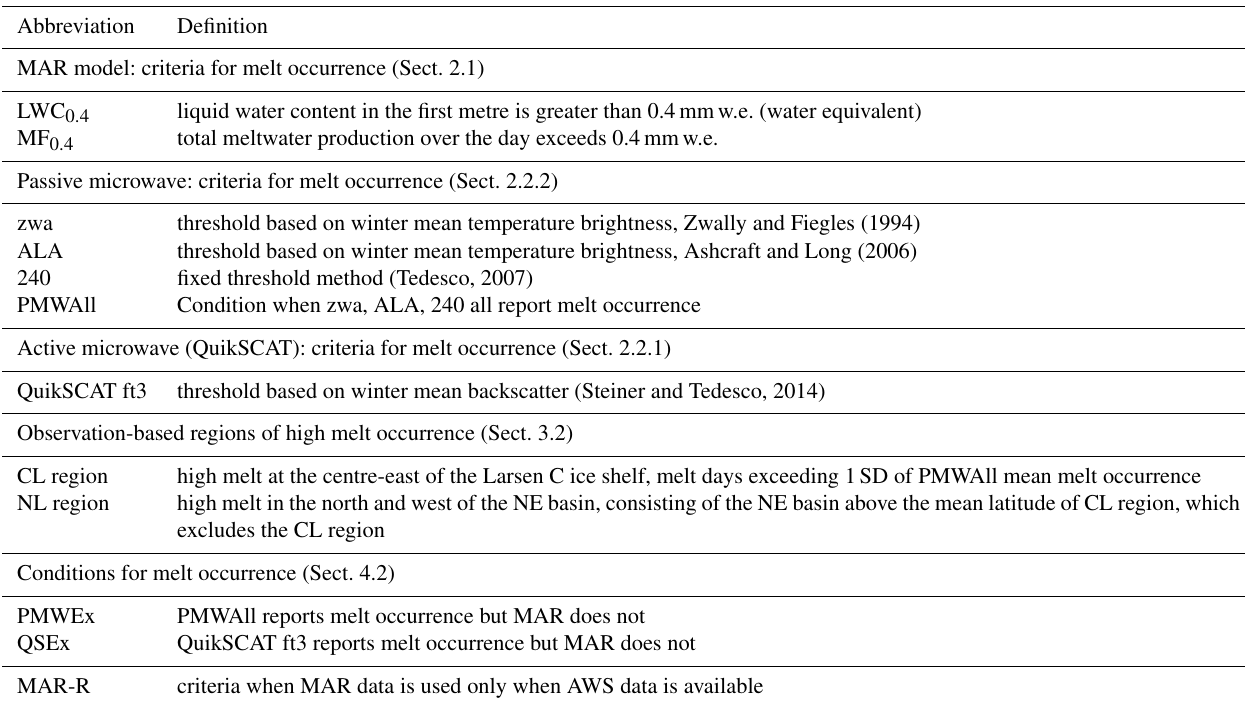
Table 1. Abbreviations used throughout